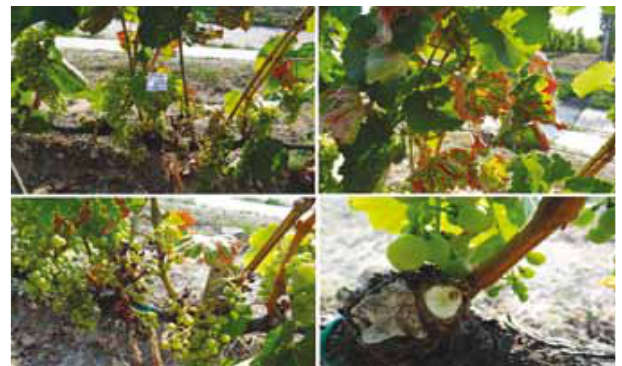
Figure 3: Esca symptoms on Furmint variety in Tokaj Wine Region Photo: Kovács and Balling,